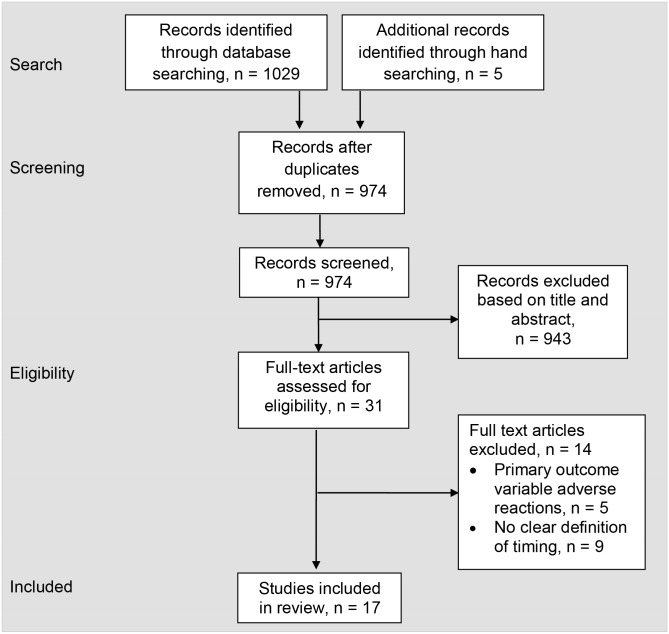
PRISMA flow diagram.